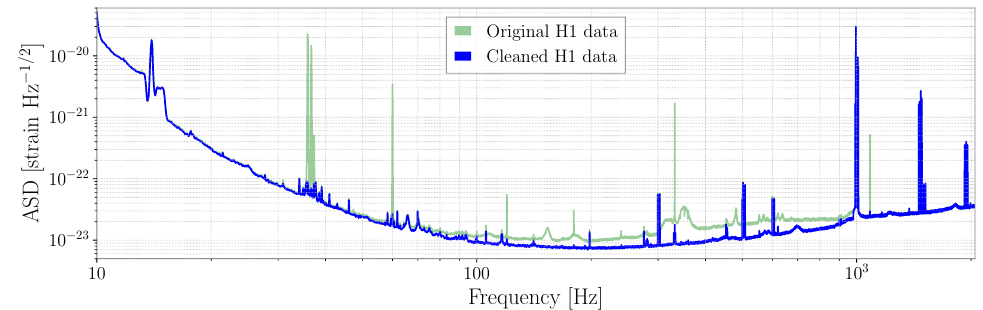
Figure 9. A comparison of the amplitude spectral density (ASD) of the strain data at LIGO Hanford (H1) before (green) and after (blue) subtraction of broadband noise in O2. By using instrumental witnesses to known sources of noise, broadband noise between 80 and 1000 Hz was significantly reduced, as well as elimination of many narrow frequency band spectral artifacts caused by calibration lines and other instrumental factors. Figure is reproduced from [130]. © IOP Publishing. Reproduced with permission. All rights